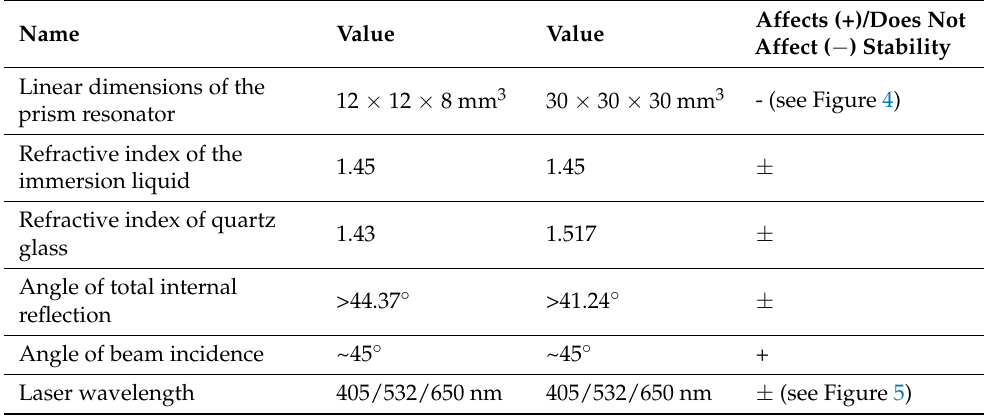
Table 2. Experimental parameters and their impact on beam trajectory